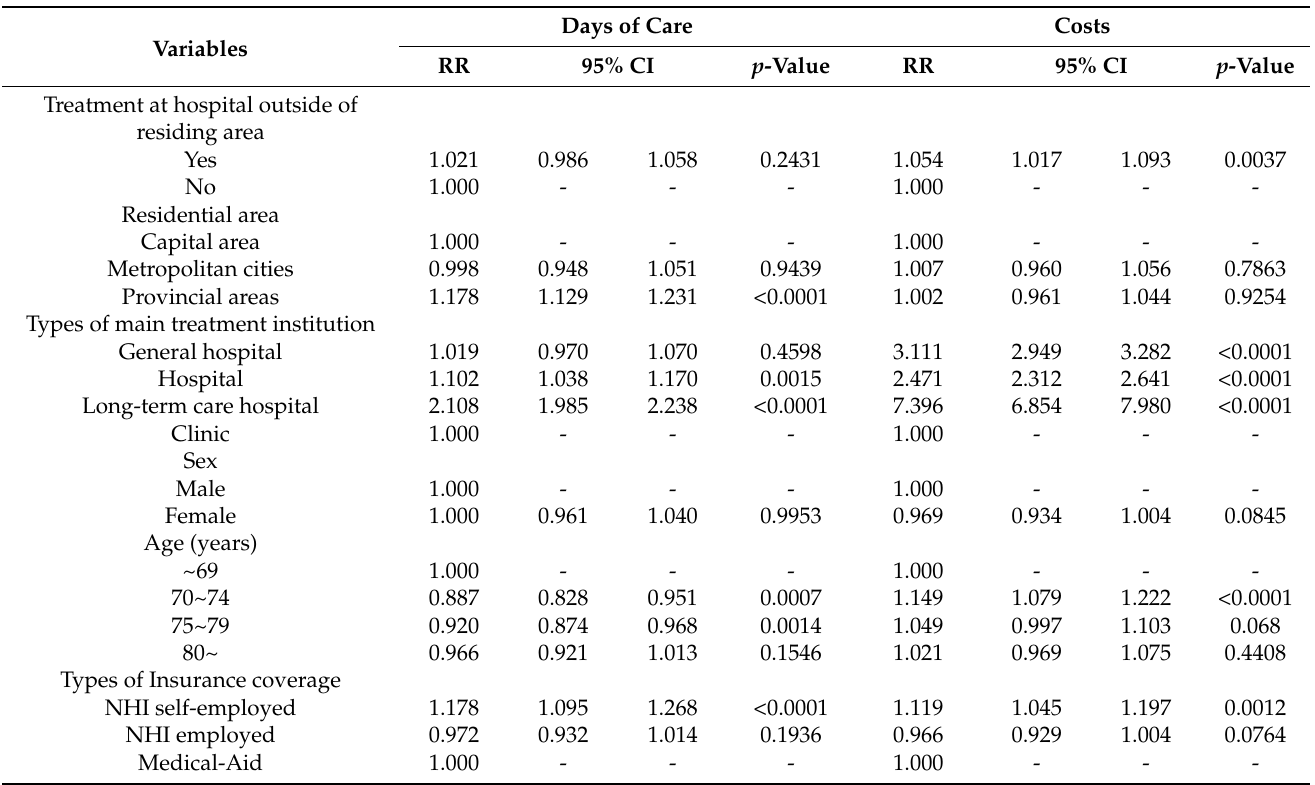
Table 3. Association between area of residence and days of care and healthcare